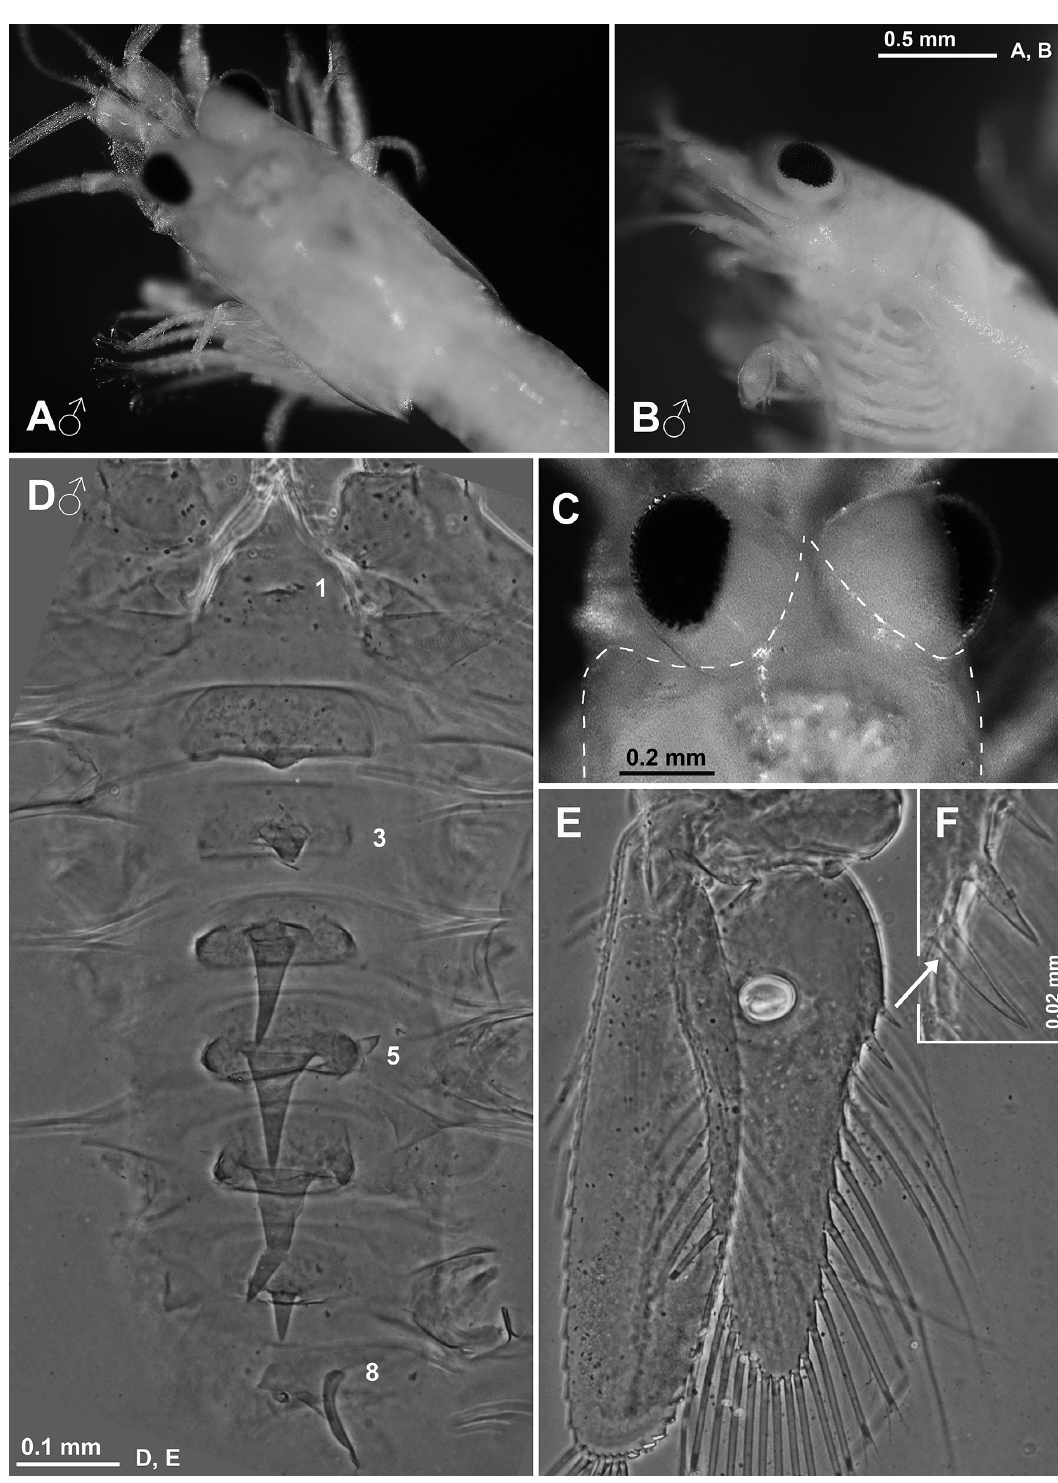
Fig. 1. Heteromysis smithsoniana sp. nov. A–C . Holotype, ♂ with body length 3.6 mm (NHMW 26968). D–F . Paratype, ♂ 4.8 mm (NHMW 26971). A . Cephalothorax, dorsal. B . Cephalothorax, lateral. C . Head region, obliquely dorsal; dashed line illustrates anterior contour of carapace. D . Thoracic sternites expanded on slide, ventral. E . Uropods, dorsal. F . Detail of uropods (E) showing spines of endopod. A–F. Ethanol–fixed materials on petri dishes (A–C) and slides